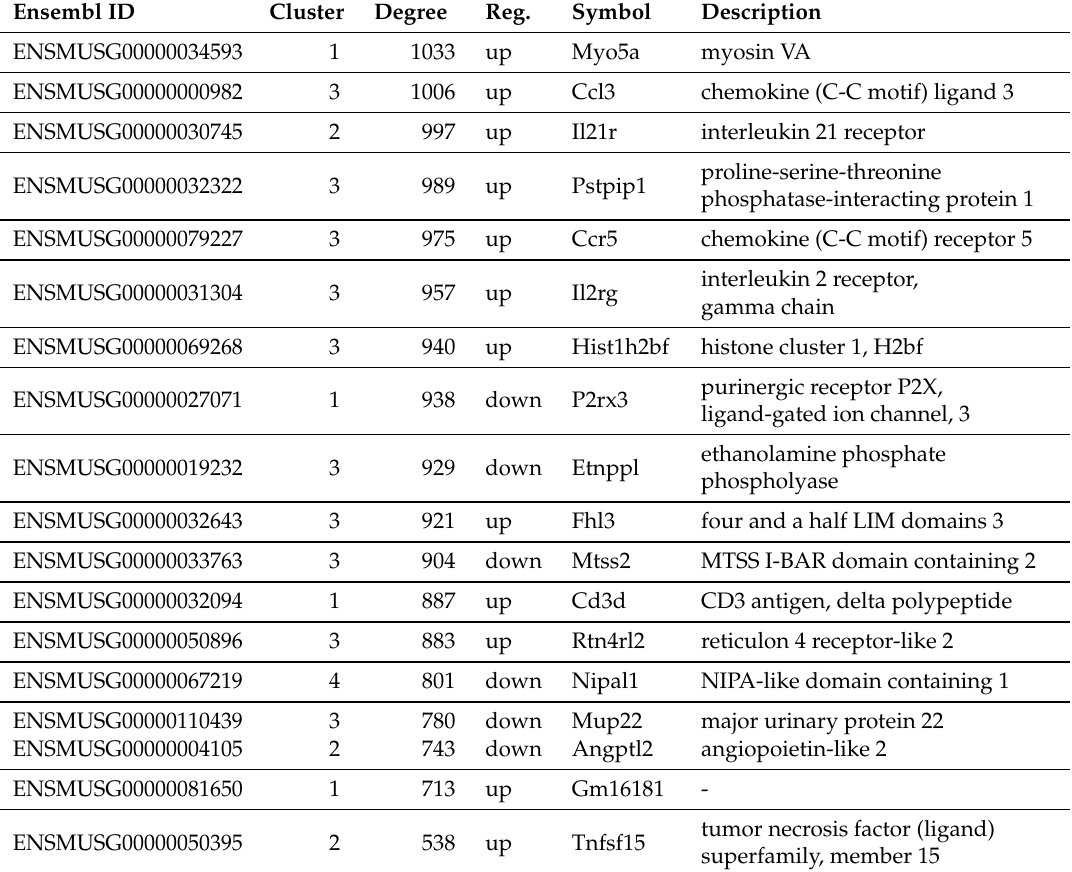
Table A2. Hubs identified in the network reconstructed from liver wt samples. Degree cutoff: 24. Reg.